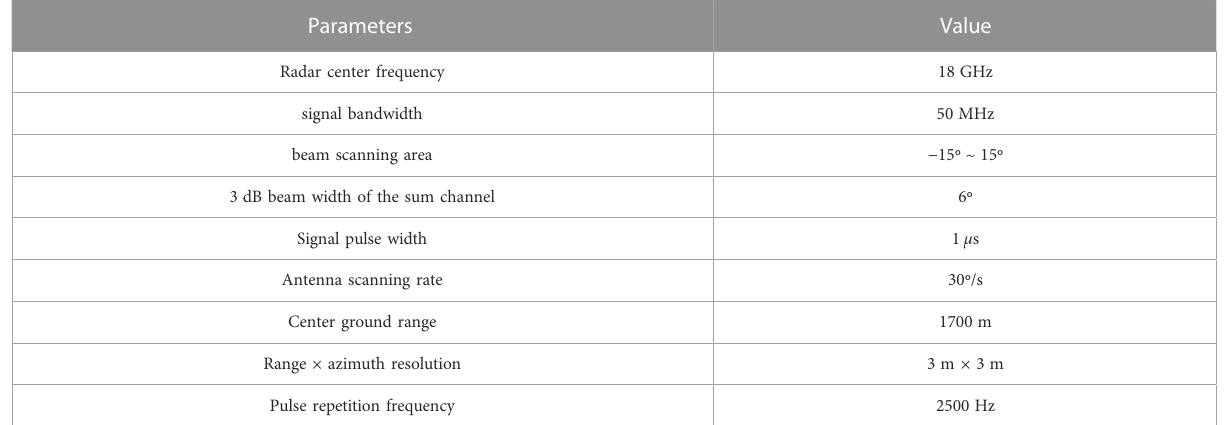
TABLE 1 Simulation parameters for forward-looking scanning